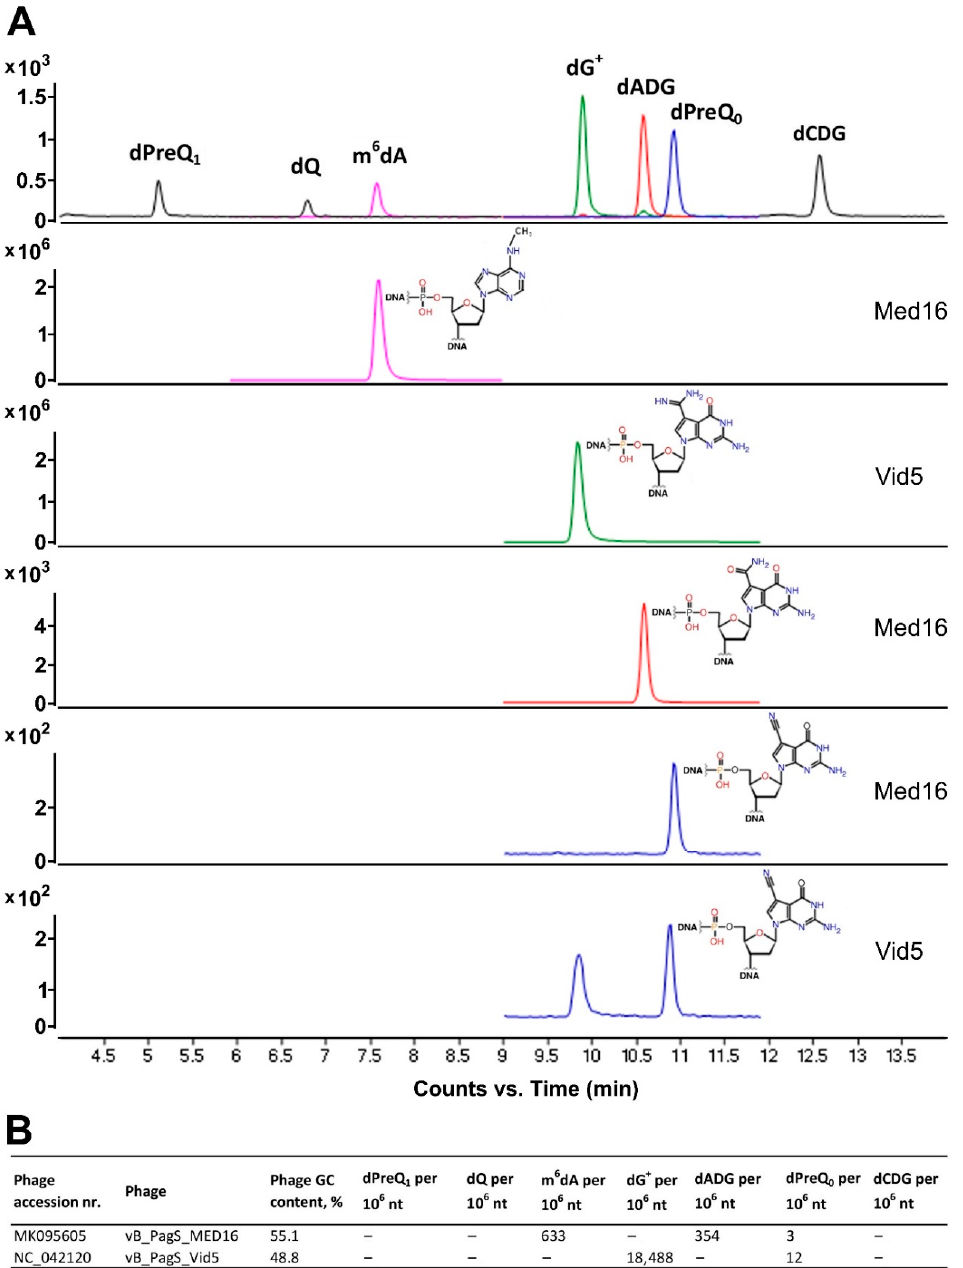
Figure 3. LC–MS/MS chromatograms of digested DNA samples of MED16 and Vid5 phages ( A ) and quantitative results of 7-deazaguanine derivatives and m6dA in MED16 and Vid5 phages ( B ).